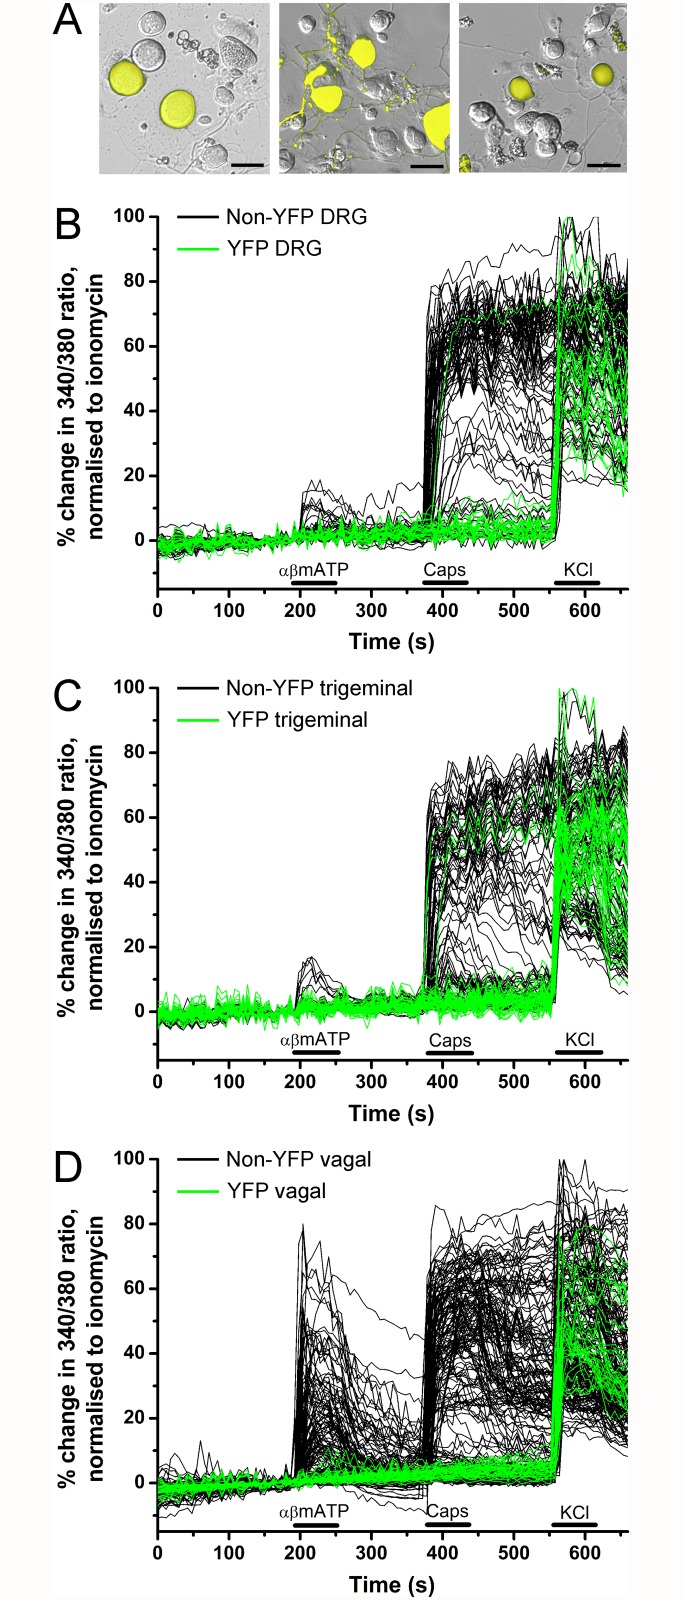
YFP-expressing sensory neurons are insensitive to capsaicin and α,β methylene ATP.
A, representative fluorescent images of YFP expression (yellow) in dissociated neurons overlaid upon bright field image: DRG (left), trigeminal (middle) and vagal (right). Scale bar represents 35 μm. B-D, Ca2+ responses of individual dissociated DRG neurons (A), trigeminal ganglia neurons (B) and vagal ganglia neurons (C) in response to α,β methylene ATP (10 μM), capsaicin (Caps, 1 μM,) and KCl (75 mM). Green lines for YFP neurons, black lines for non-YFP neurons. Blocked lines depict the duration of drug application.